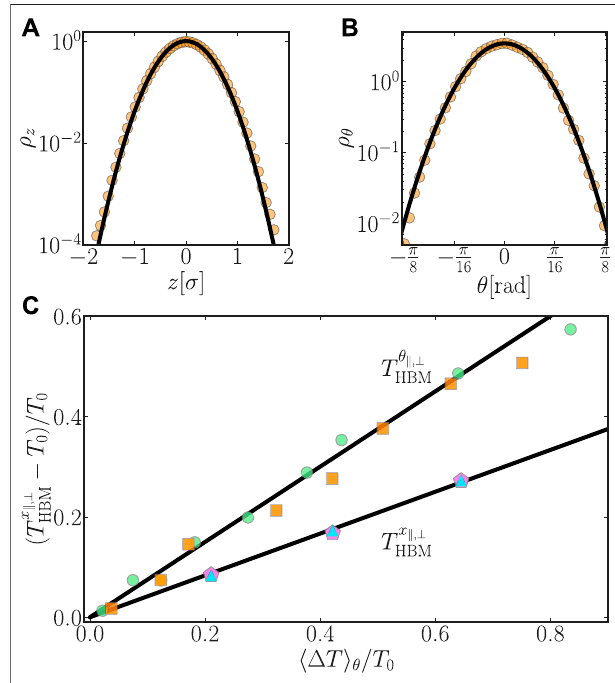
FIGURE3 | Upper panels: Histograms ofharmonically con fi ned position (A) and orientation (B) of the Janus particle heated to T P (cid:2) 1 . 0 ϵ / k B in (A) and T P (cid:2) 1 . 0 ϵ / k B in (B) . Histograms were fi tted by Gaussian pro fi les (lines) to extract the corresponding effective temperature T HBM . (C) Lower line and data: Numerically measured T x (cid:4) HBM (blue triangles), T x ⊥ HBM (pink pentagons) for translation along/transverse to the symmetry axis of a heated Janus particle against the theory from Eq. 35 , Eq. 36 . Upper line and data: T θ (cid:4) HBM (orangesquares)forrotationaroundtheparticle ’ ssymmetryaxis,and T θ HBM for an isotropic, homogeneously heated Brownian particle [51] (green circles) versus theory from Eq. 42 , neglecting the small correction term (which would hardly be discernible, anyway). In all simulations, the wetting parameters were c ps (cid:2) 1 and c gs (cid:2)